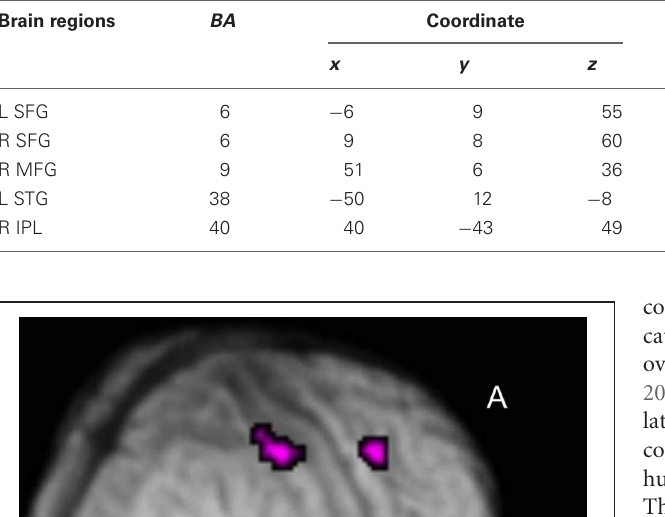
Table 4 | Positive correlation between PANSS and cerebral activation under FJT minus GDT, p < 0 . 0001 uncorrected ( p < 0 . 25, FDR-corrected), R, right hemisphere.